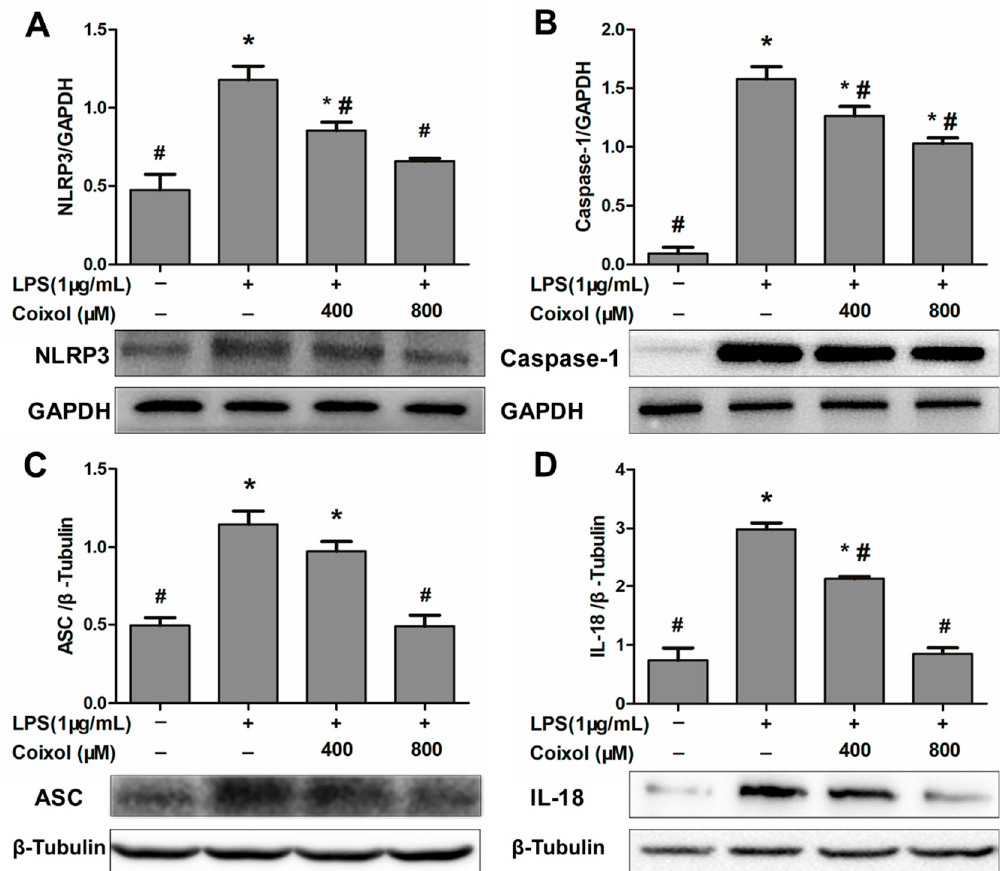
Figure 6. Effects of coixol on NLRP3 inflammasome activation in LPS- induced RAW 264.7 cells. Cells were pretreated with coixol for 4 h and then stimulated with 1 μ g/mL LPS for 4 h. The protein levels of ( A ) NOD-like receptor protein (NLRP) 3, ( B ) caspase-1, and ( C ) apoptosis-associated speck-like protein containing CARD domain (ASC) and ( D ) interleukin (IL)-18. Protein levels were measured by western blotting. GAPDH and β -Tubulin were used as internal controls. The data represent the mean ± SD ( n = 3). * p < 0.05 vs. control group. # p < 0.05 vs. LPS group.